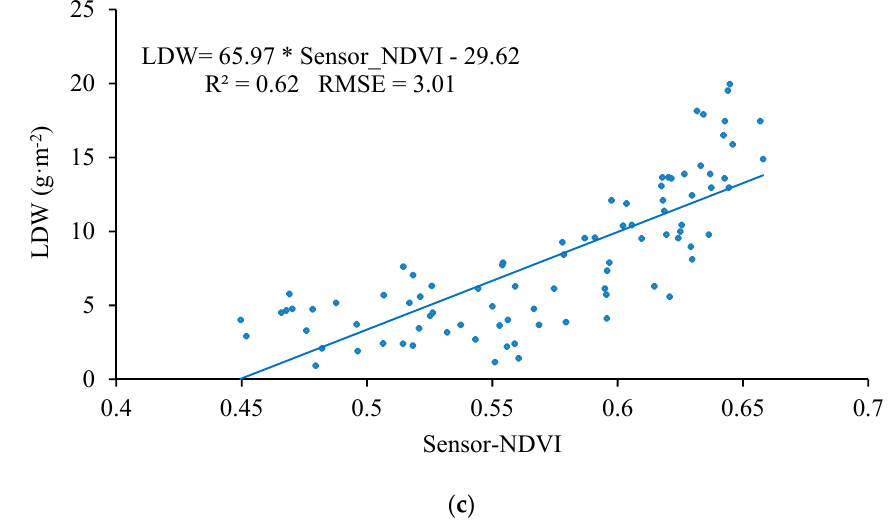
Figure 17. The spectral model for the UAV-borne crop-growth monitoring system. ( a ) LNA-RVI/NDVI fitting curve; ( b ) LAI–RVI/NDVI fitting curve; ( c ) LDW–RVI/NDVI fitting curve.